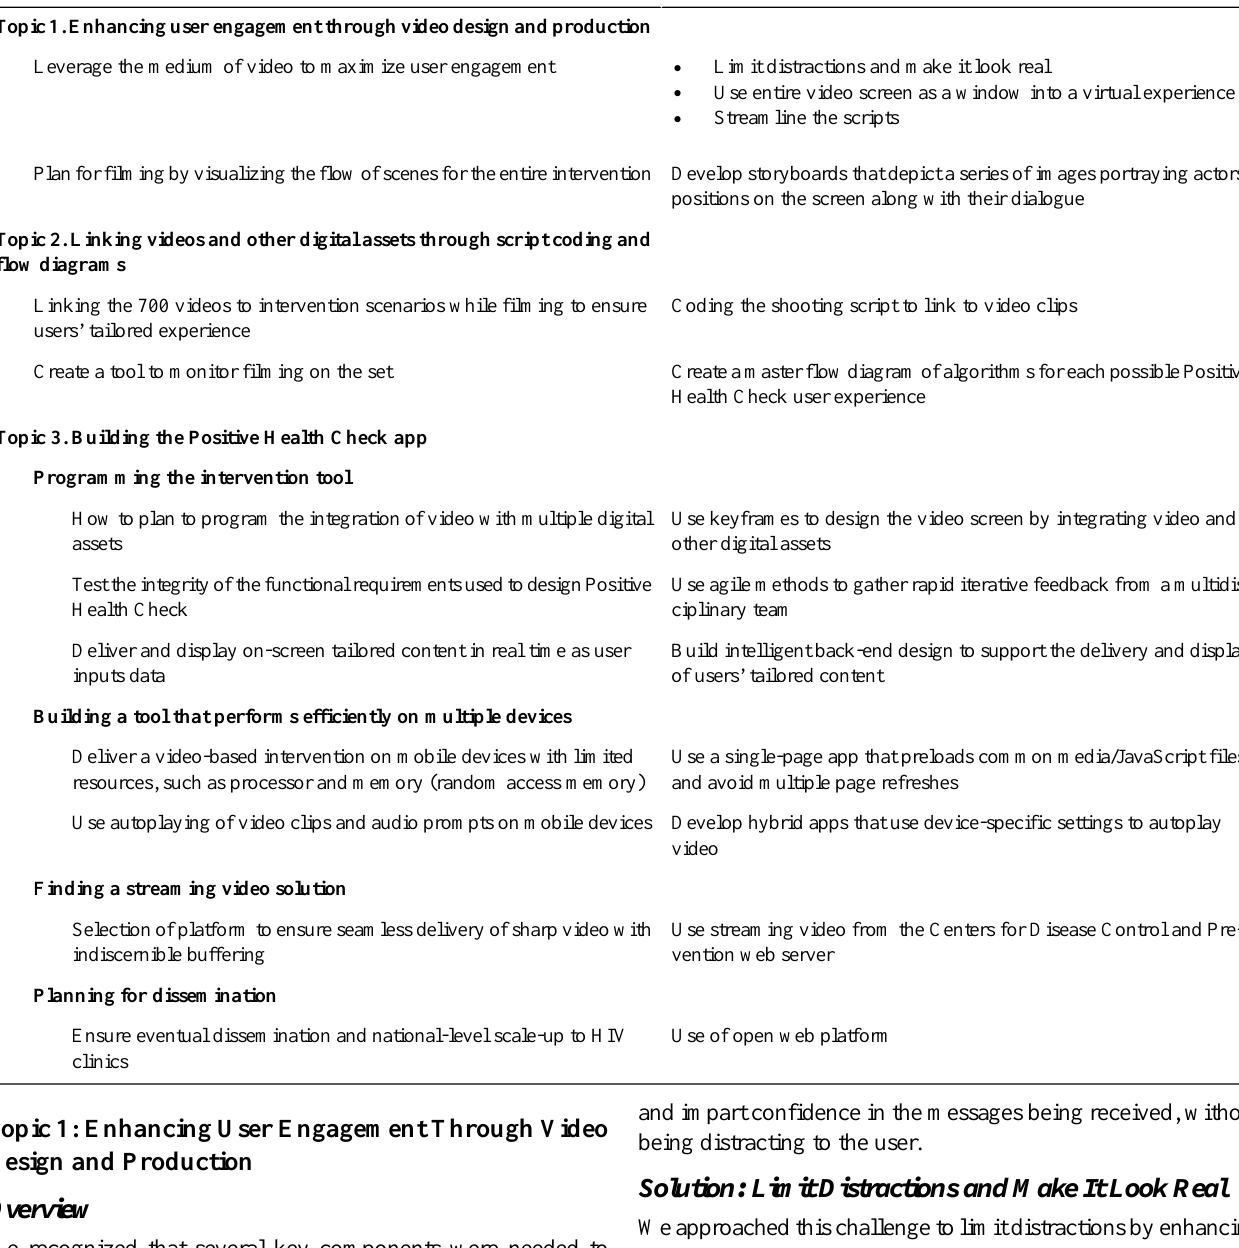
Table 1. Overview of challenges to and solutions for designing and developing Positive Health Check.